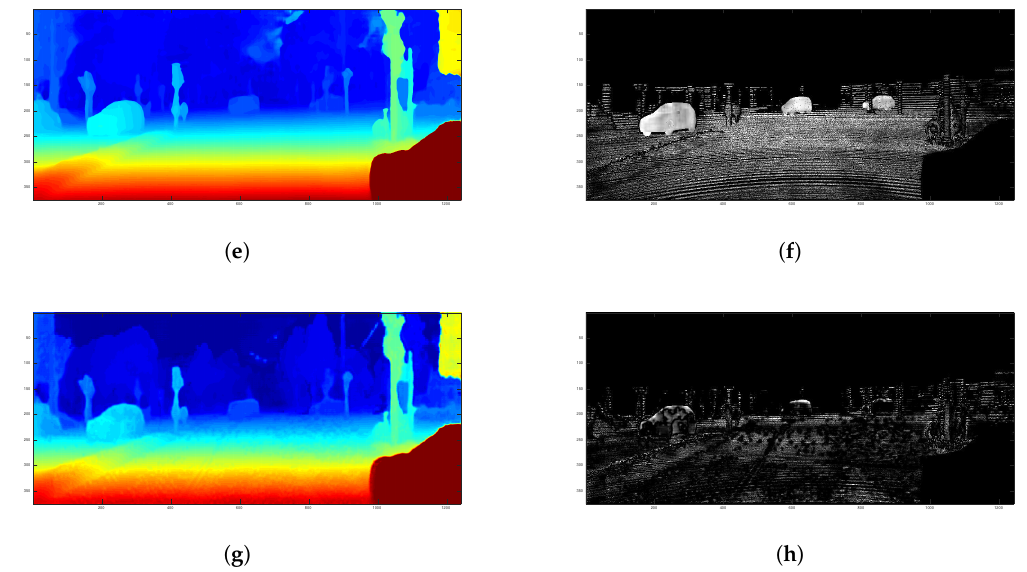
Figure 7. We trained our network to fuse the initial disparity maps ( c , e ) into a refined disparity map ( g ) for the same scene ( b ) from the Kitti2015 dataset [26] using our supervised method. ( a ) is the corresponding ground truth. ( d , f , h ) are the errors of ( c , e , g ). The lighter pixels have bigger disparity